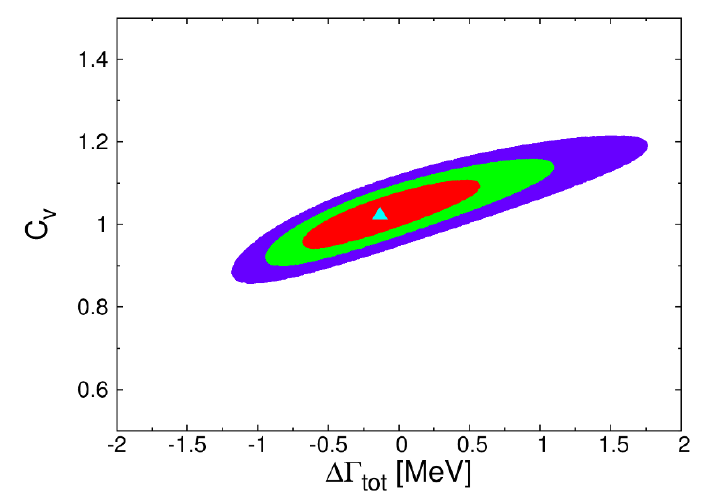
Figure 9 . CPCX2 : the con(cid:12)dence-level regions of the (cid:12)t by varying C v and (cid:1)(cid:0) tot . The color code is the same as in (cid:12)gure 2.